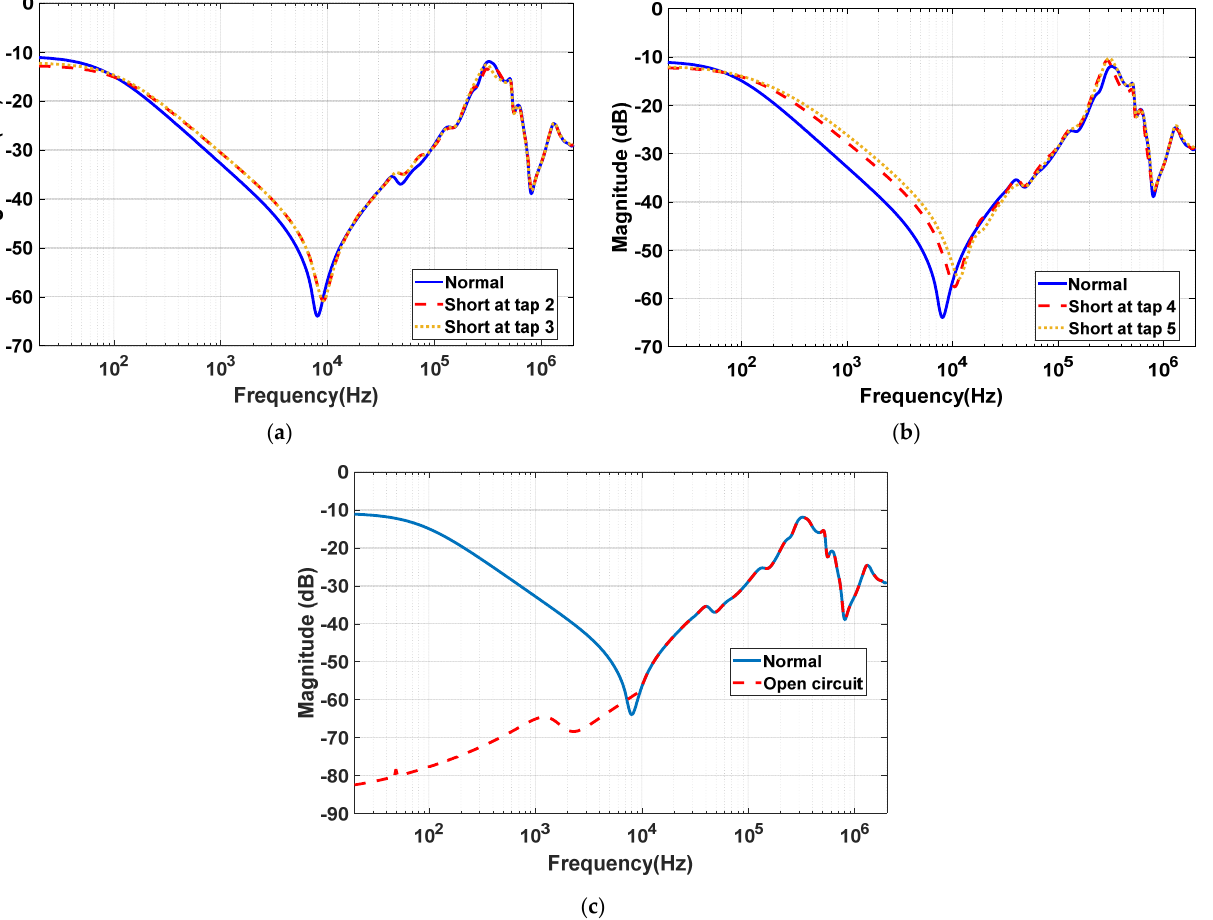
Figure 4. FRA measurement for the tested transformer winding at ( a ) Normal vs. SC at tap 2 and tap 3 ( b ) Normal vs SC at tap 4 and tap 5 ( c ) Normal vs. OC.